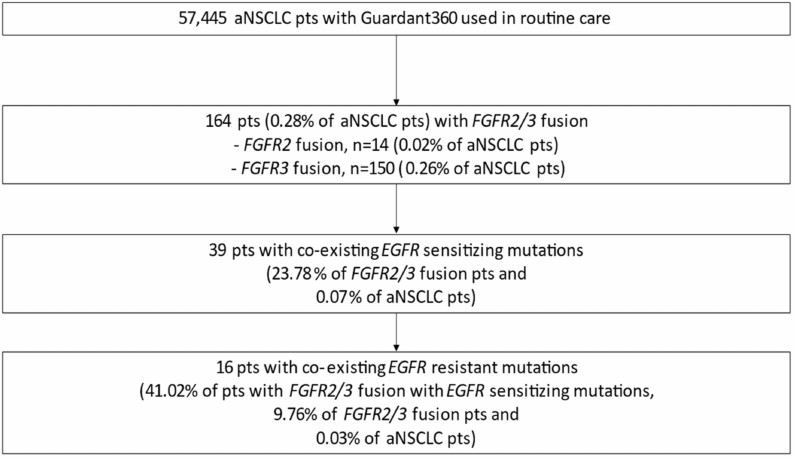
Figure 1. Prevalence of FGFR2/3 fusions and co-existing EGFR sensitizing and resistant mutations in aNSCLC in the GH electronic database. Abbreviations: aNSCLC—advanced non-small cell lung cancer; EGFR—epidermal growth factor receptor; FGFR—fibroblast growth factor receptor; GH—Guardant Health; pts—patients.